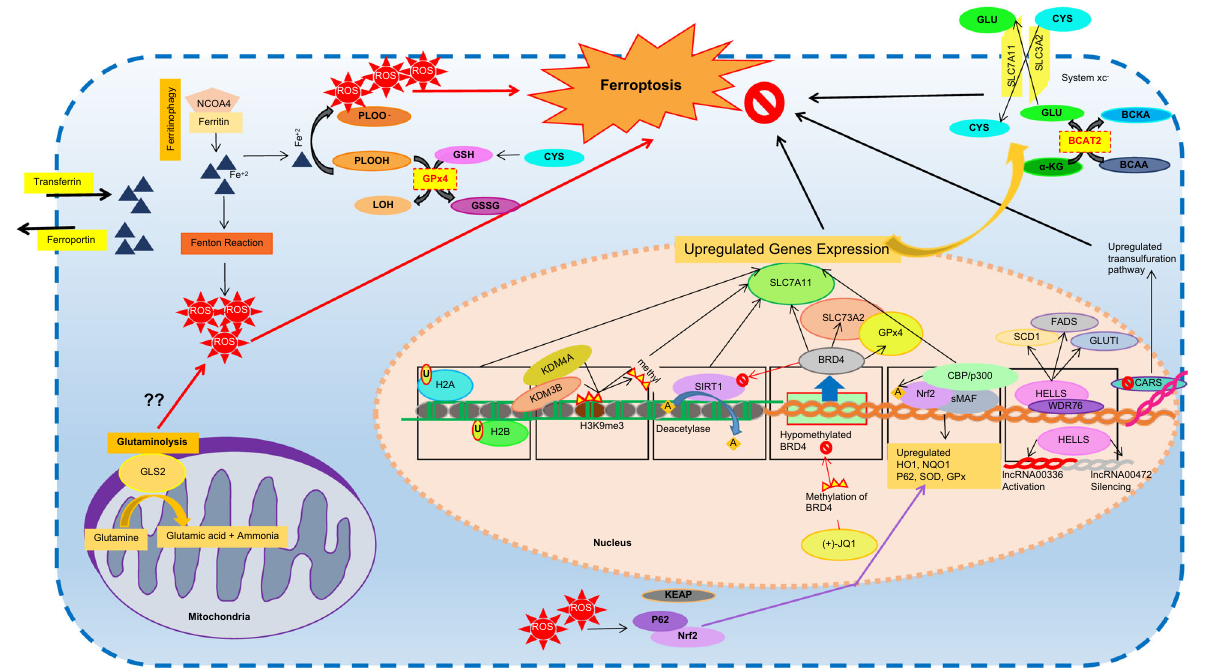
Fig. 3 Epigenetic regulation of ferroptosis. Intracellular mechanism of ferroptosis regulated at various levels. In mitochondria, glutaminolysis increase ROS production via unkown mechanism and contributes to ferroptosis. At nuclear level, histone modi fi cations such as ubiquitination, demethylation, or deacetylation; DNA transcriptional regulation via hypomethylation at speci fi c loci, transcriptional factors, lncRNA; and metabolic regulation through proteins; inhibit